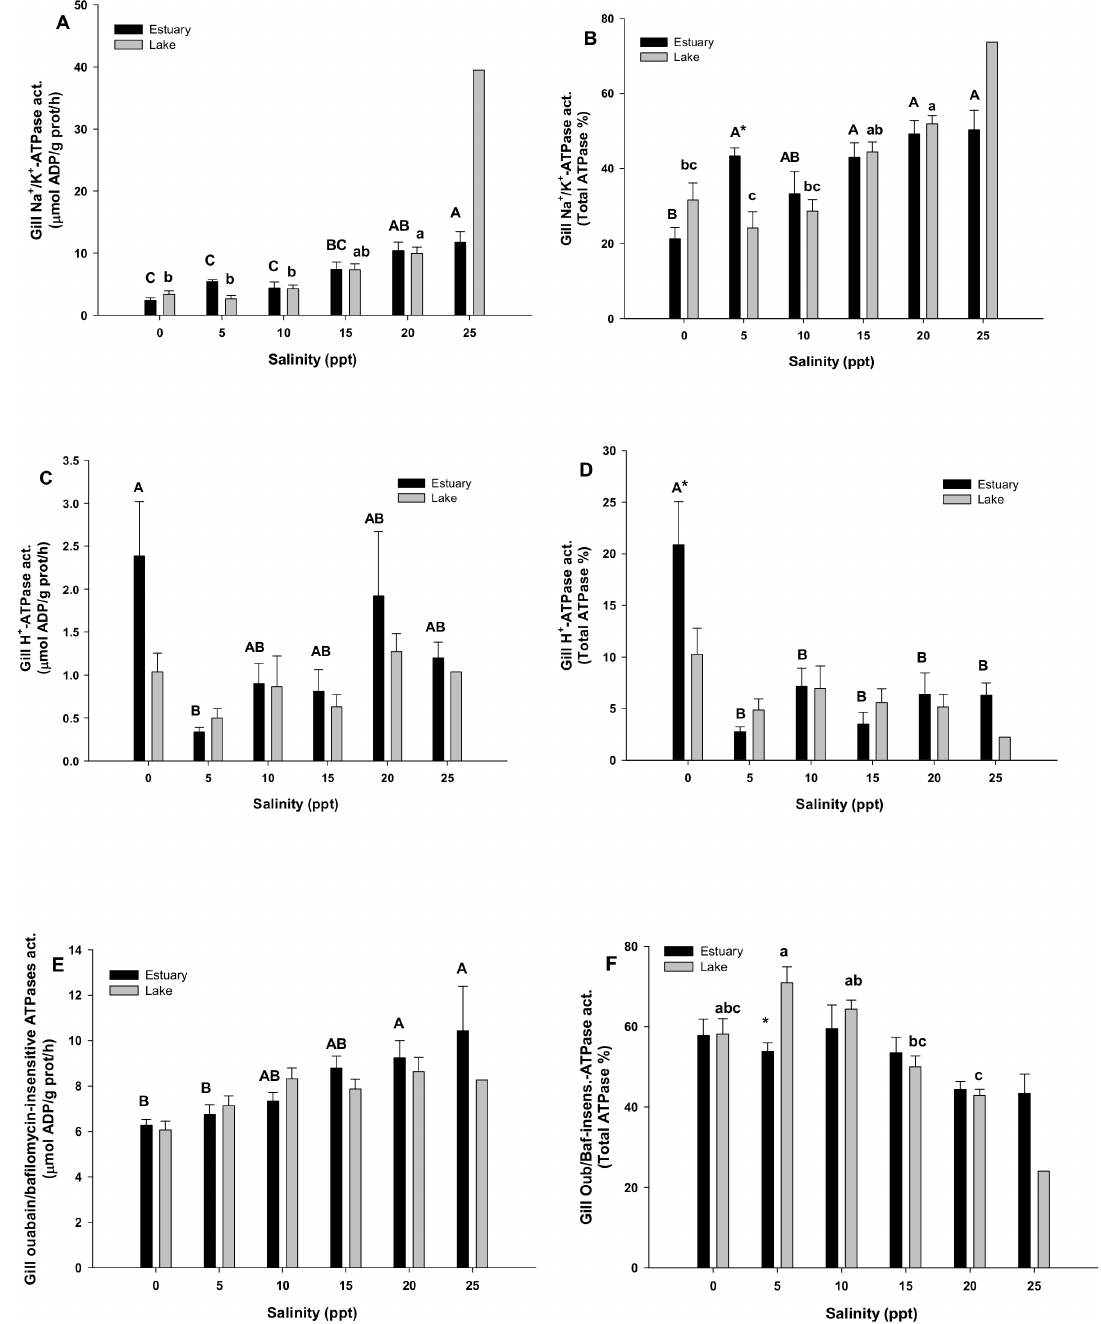
Fig 5. Branchial Na + /K + -ATPase, H + -ATPase and Ouabain/Bafilomycin-insensitive ATPases activities: (A, B and C) and % from the total ATPase activity (D, E and F) in G . maculatus juveniles, from two separated populations (diadromous from an estuary, black bars; and freshwater from a lake, grey bars), acclimated to different environmental salinities for 8 days. Values are mean ± SEM (N = 6, except for the Lake population, N = 1). Different letters indicate significant differences between groups. Major letters refer to the estuary population, while lowercase letters do it for the lake population. Asterisks ( * ) indicate significant differences between populations at the same environmental salinity (Two way ANCOVA, p < 0.05).